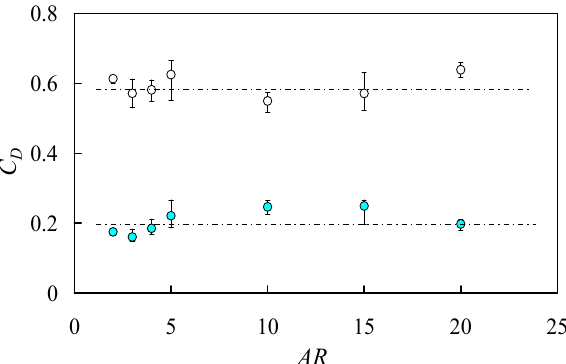
Fig. 9 Drag coefficient C D versus aspect ratio AR at depth-to-width ratio λ = 0.3, C = 3.86 × 10 2 .